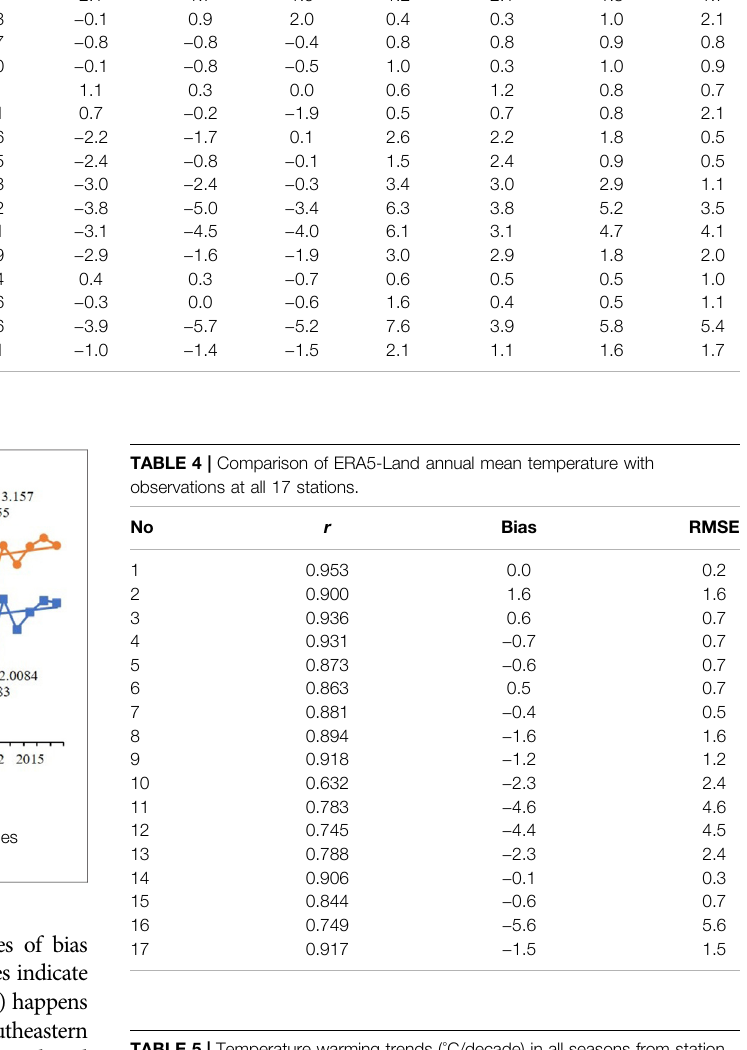
TABLE 5 | Temperature warming trends ( ° C/decade) in all seasons from station time series and ERA5-Land reanalysis in 1979 –